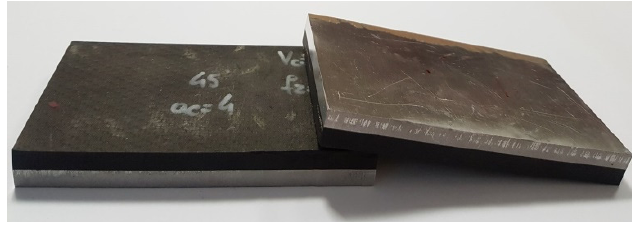
Figure 4. Samples after milling.